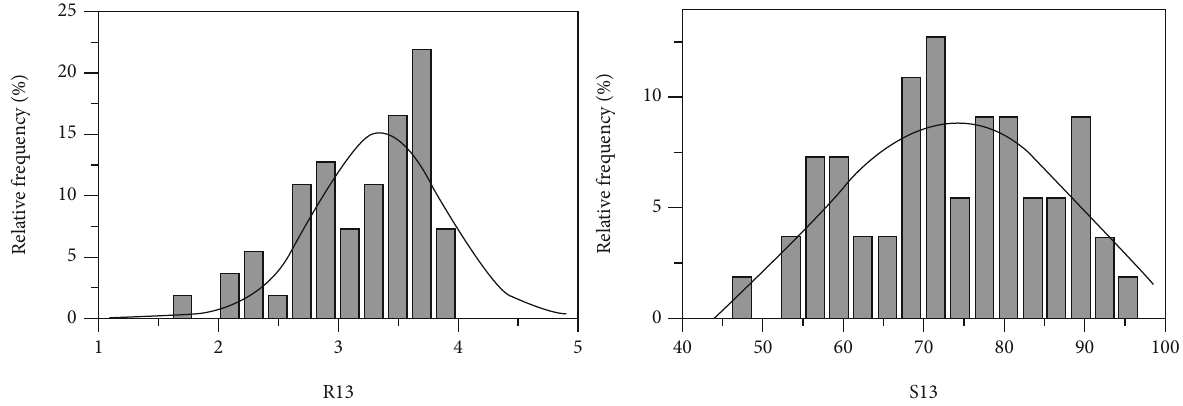
Figure 7: Probability density distribution of the random variables in accommodation conditions for engineering geology practice ( R 13 , S 13